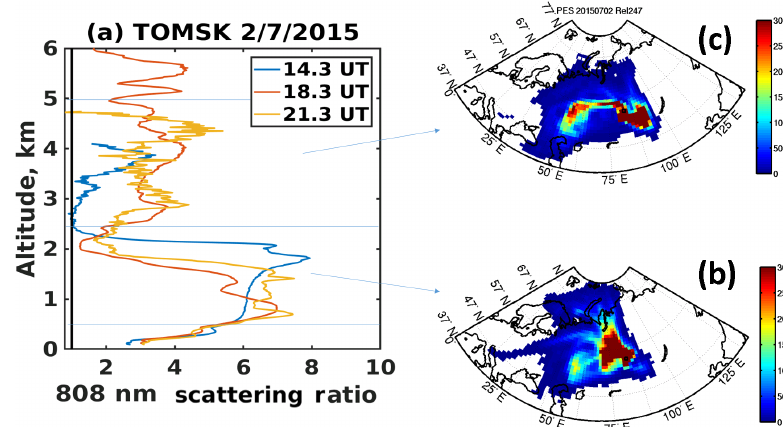
Figure 11. As Fig. 10 on 2 July 2015 at 14:20, 18:20 and 21:20UT.